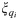
Flowchart of the PhyQuart algorithm.Simplified flowchart showing a) each of the three possible quartet relationships for a set of 4 sequences (q1, q2, q3), b) the site-pattern classification of observed (Nobs) symmetric (ξqi) and asymmetric (σqi) support (τqi), c) the determination of plesiomorphic (old) split-supporting site-patterns given two different polarities of character transformation along the internal branch of each possible quartet tree, ρq1→ and ρq1←, and d) estimation of expected convergent split-supporting site-patterns (κq1→,κq1←) supporting quartet q1 in ML split pattern estimations using branch length and model optimization on constraint topologies of the other two possible quartet relationships (q2, q3).